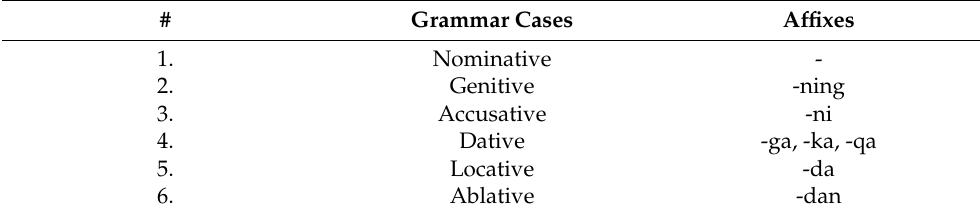
Table 6. Singular and plural forms of